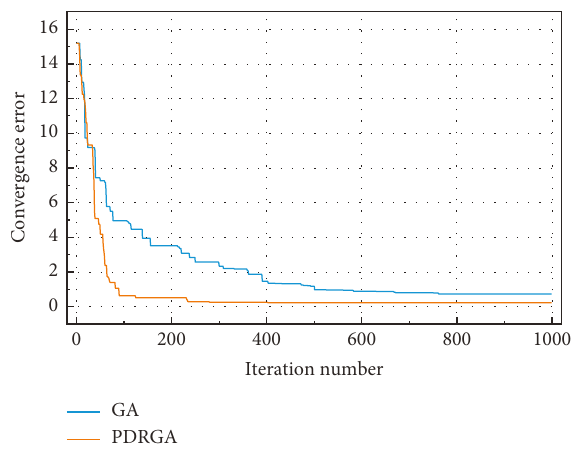
Figure 12: Comparison diagram of the convergence error of the optimization algorithm.